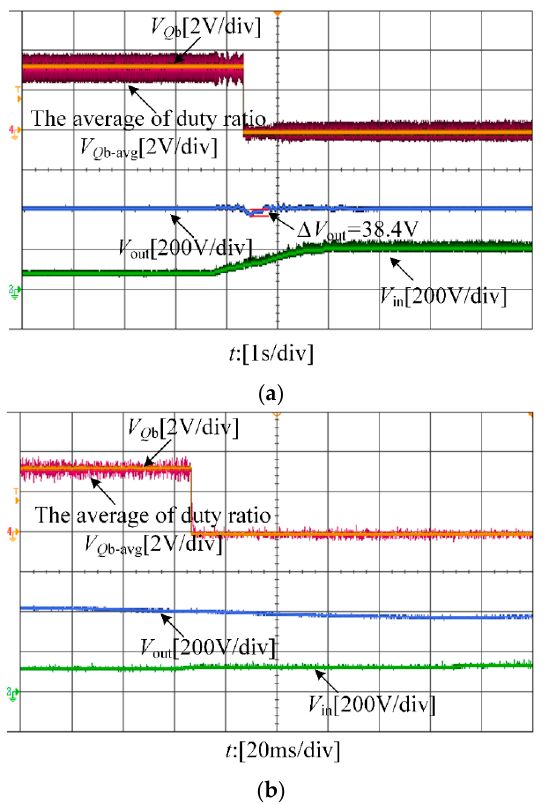
Figure 15. Experimental waveforms of transient switching process a with traditional control method. ( a ) Overall switching waveforms; ( b ) Enlarge detailed waveforms.